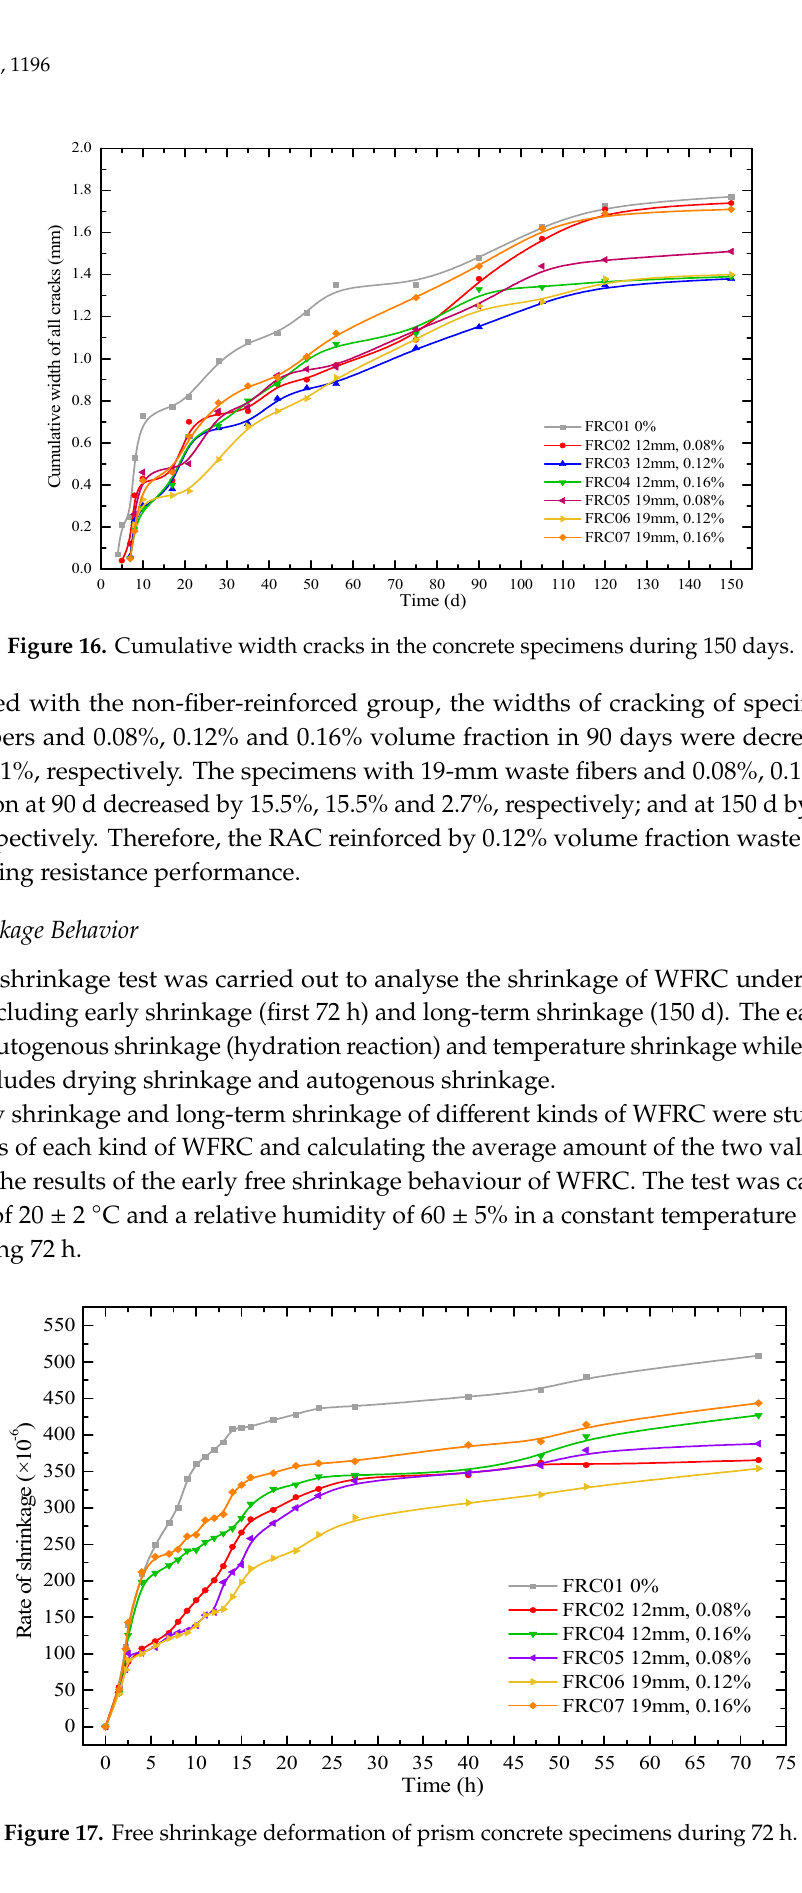
Figure 17. Free shrinkage deformation of prism concrete specimens during 72 h.